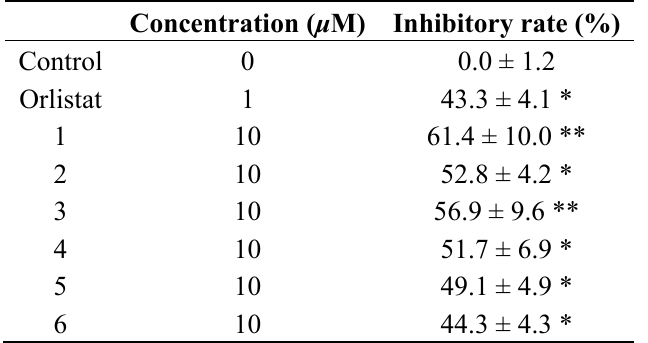
Table 4. TG accumulation inhibitory effects of 1 – 6 in HepG2